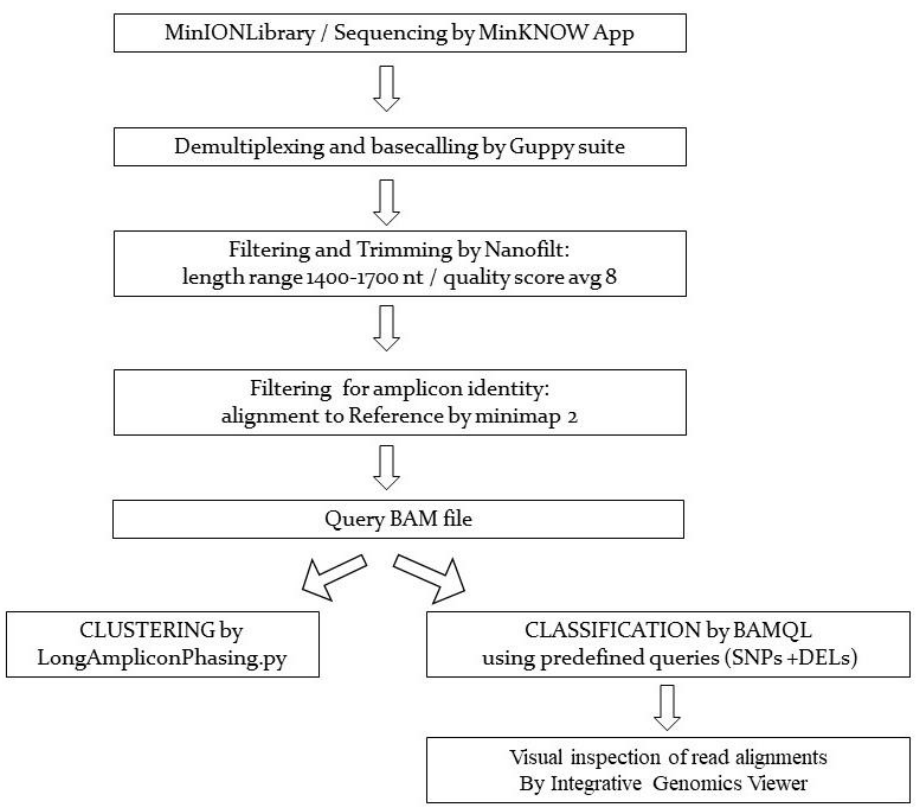
Figure 1. Workflow for library preparation, nanopore sequencing and data analysis.